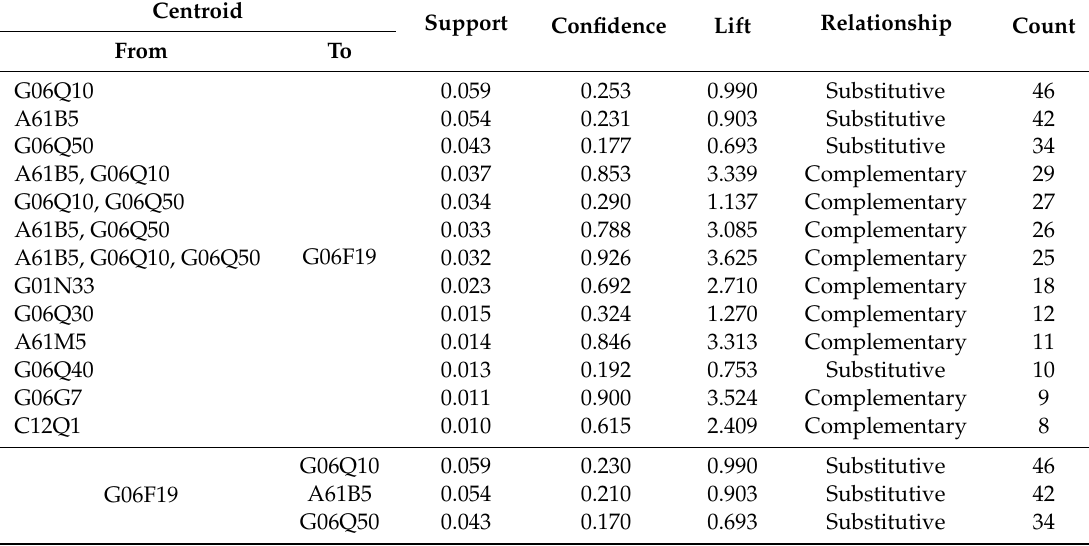
Table A2. Relationships of clusters in the science-based pharmaceutical innovation period (2000–2007).